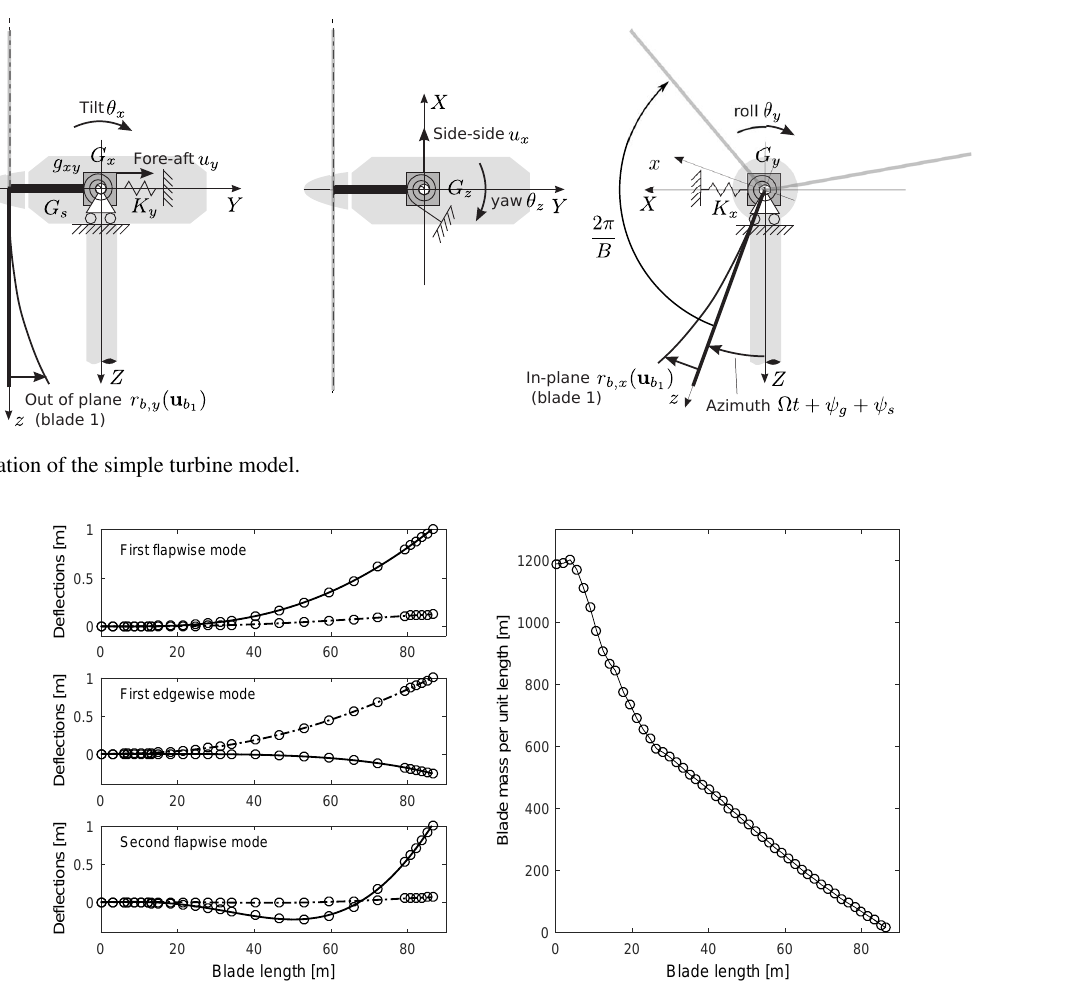
Figure 2. Edgewise (dashed curves) and flapwise (solid curves) deflections in the blade mode shapes (left plots) and the blade mass distri- bution (right plot) for the blade of the DTU 10MW RWT. Circles in the left plots are results from the beam element model of the software HAWCStab2 and the curves are polynomial fits used in the present